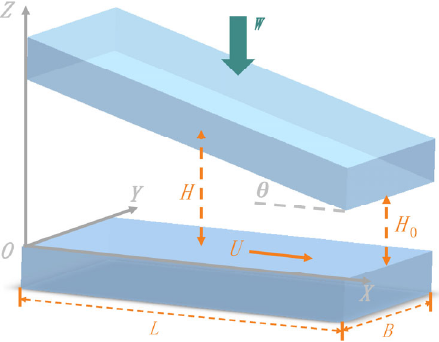
Fig. 2 Illustration of the hydrodynamic lubrication contact.